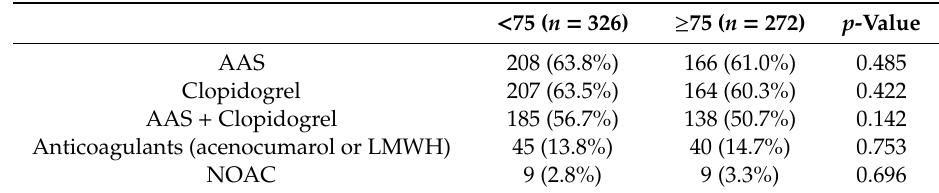
Table 4. Treatment at discharge according to age group.